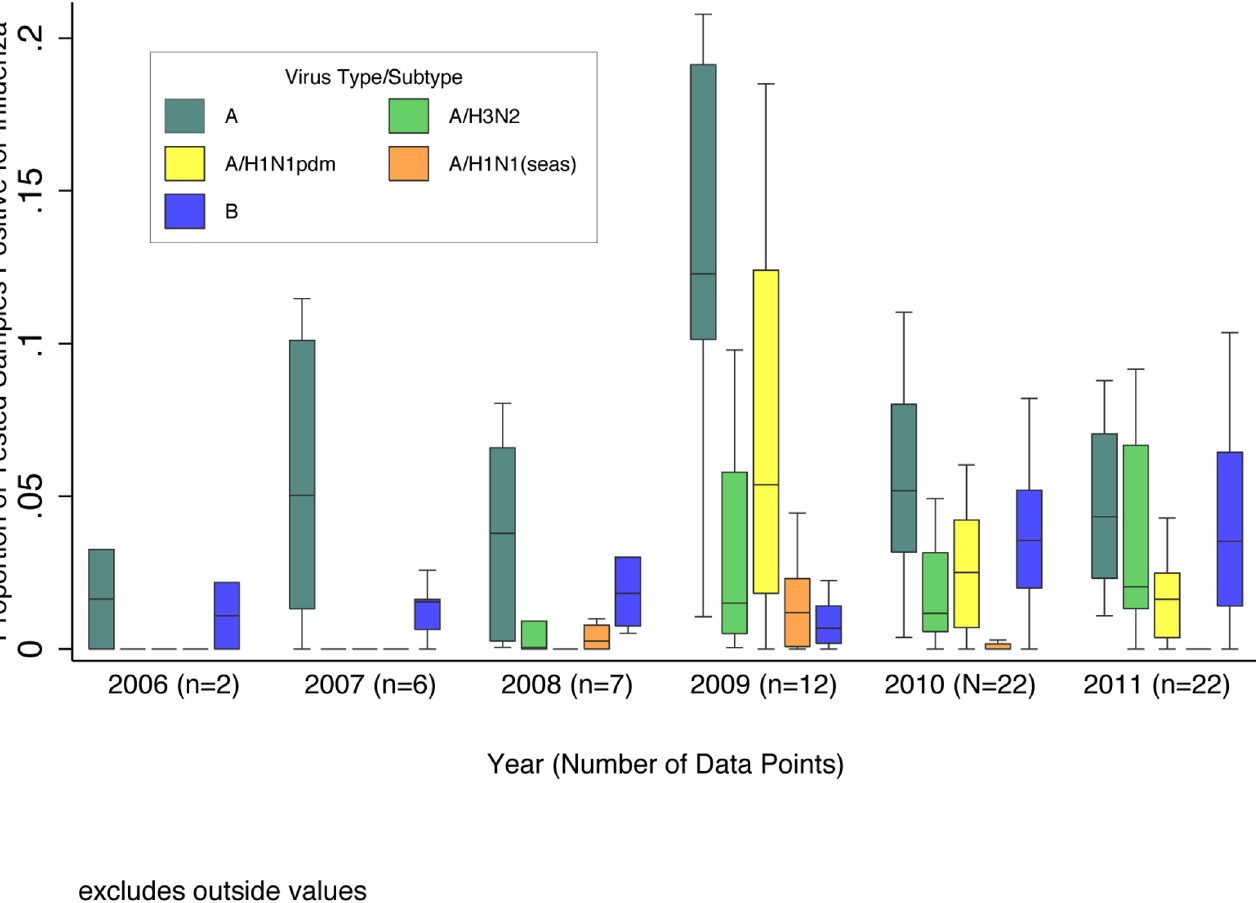
Fig 2. Boxplot of the proportion of pediatric (0 – 17 y of age) respiratory samples testing positive for influenza virus among GRIPP datasets by year and virus type/subtype. Data are for years with more than one dataset providing testing results by virus subtype. Unsubtyped influenza A viruses are included in influenza A totals, but not shown separately. Boxplot excludes outside